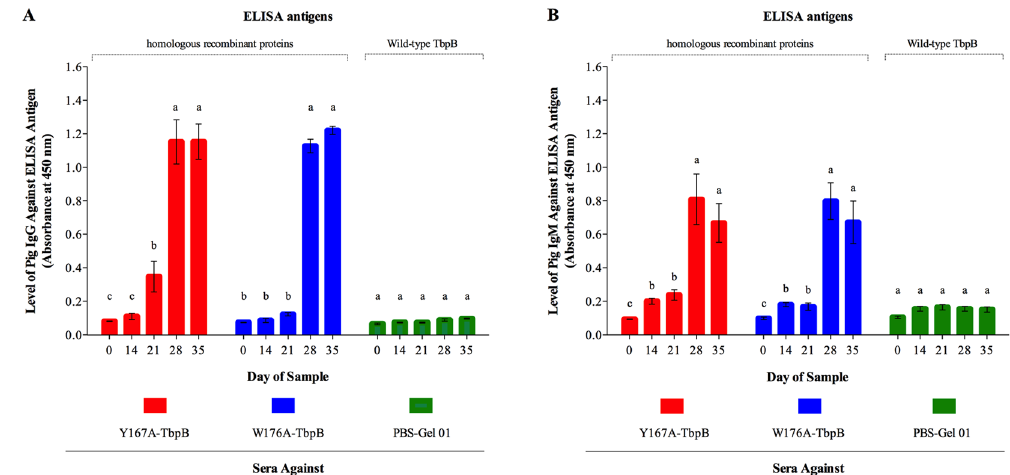
Figure 2. Kinetics of the specific antibody response in pigs. Sera collected from different time periods during the immunization schedule were diluted 1:100 and assessed by qualitative indirect ELISA. IgG responses are illustrated in the panel (A) and the IgM responses in the panel (B). Different letters indicate significant differences (p < 0.05) between the different time periods in a given